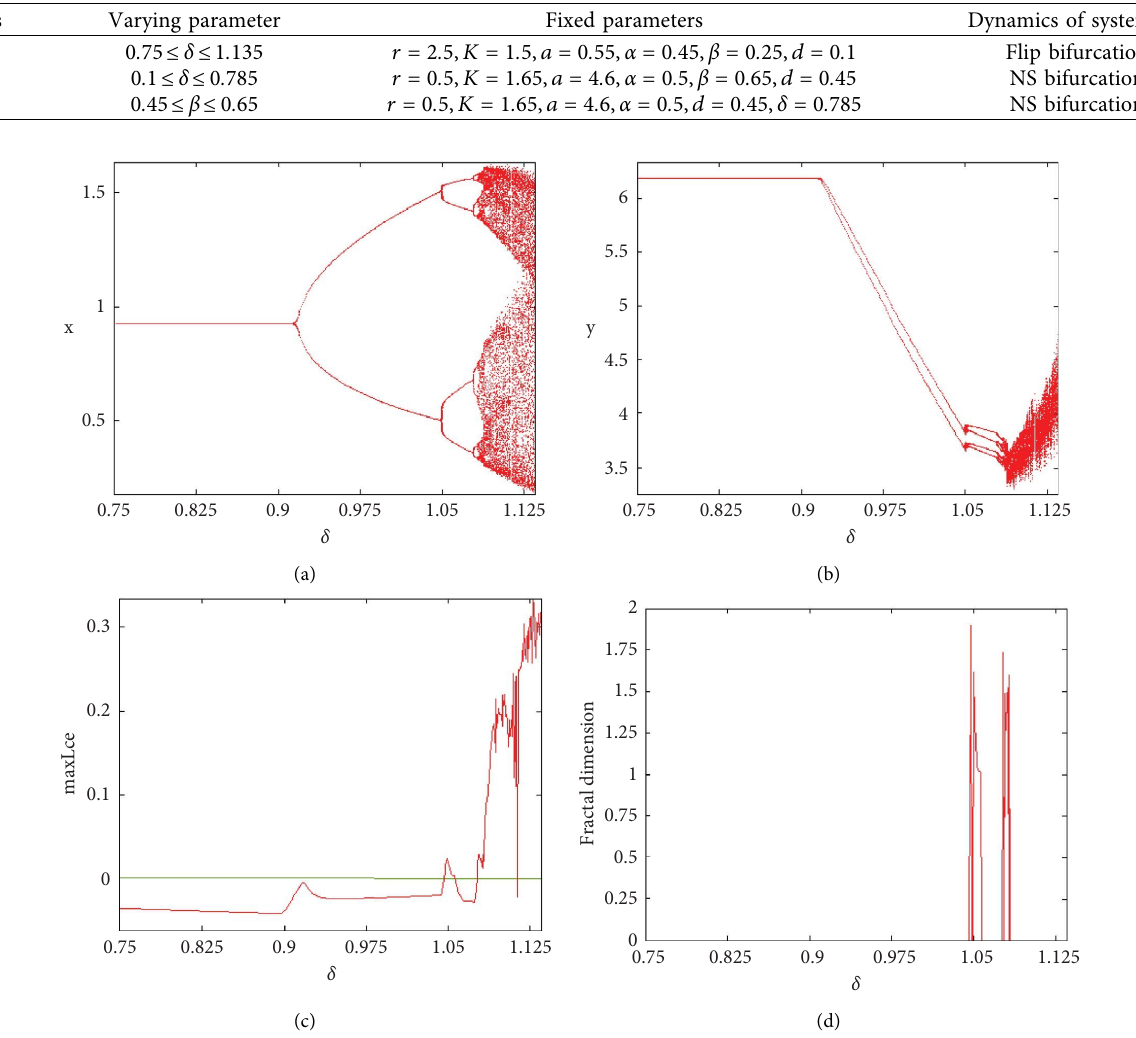
Table 1: Parameter values.